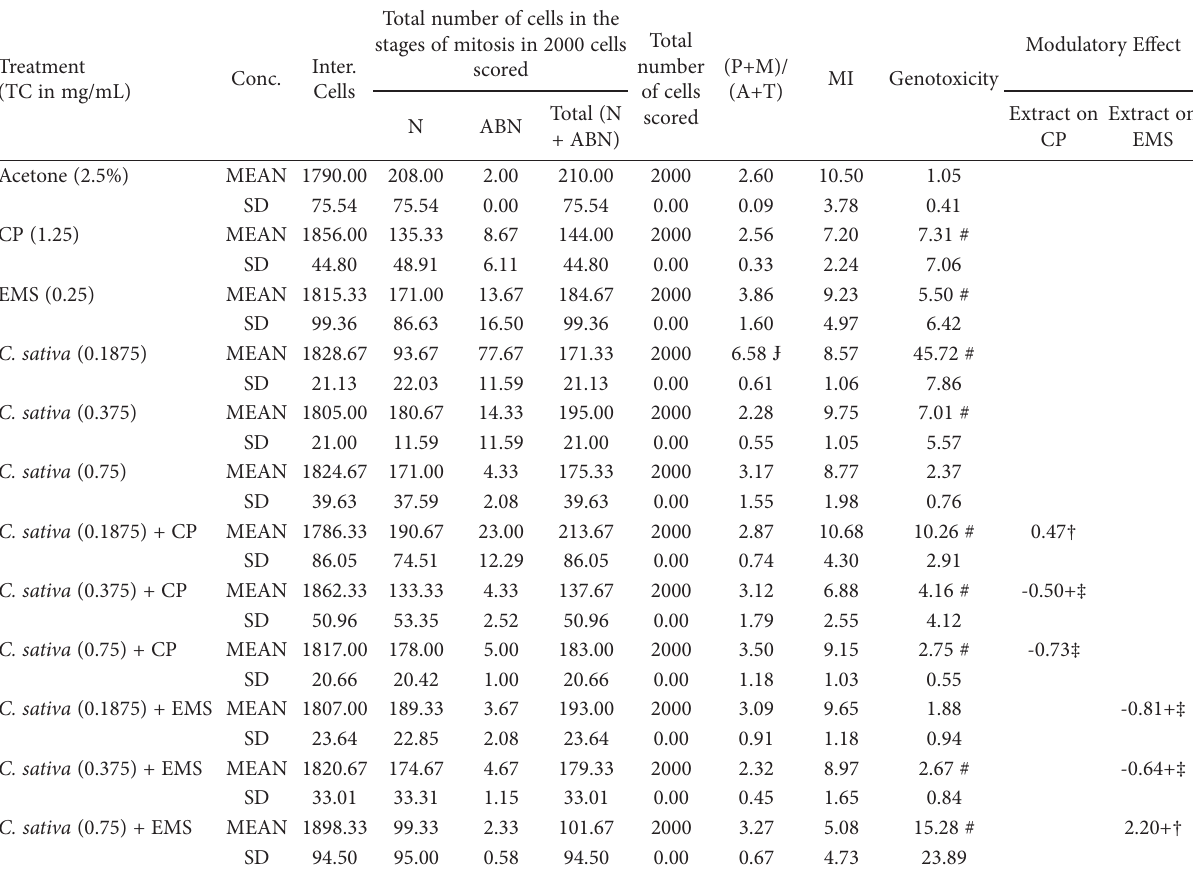
Table 4. Cytotoxic and Genotoxic effects of ethylacetate extracts of C. sativa , EMS and CP on meristem cells of onion root tip and the mod- ulatory effects (ME) of the ethylacetate extract of C. sativa on EMS- or CP-induced genotoxicity.